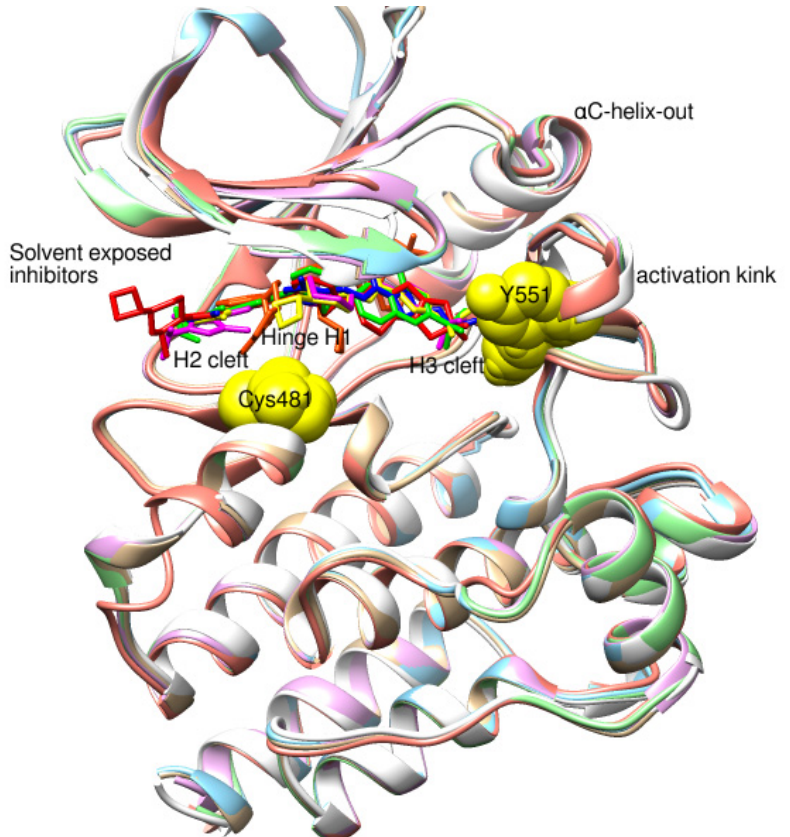
Figure 9. Overlay of 3D structures of novel non-covalent inhibitors bound to BTK-kinase domain. Protein: grey-fenebrutinib-bound (5VFI), blue-X9Y-bound (7KXQ), purple-BIIB068-bound (6W07), cyan-BIIB091-bound (7LTZ), pink-V1G-bound (6XE4), white-L-005298385-bound (6X3P). Ligands: